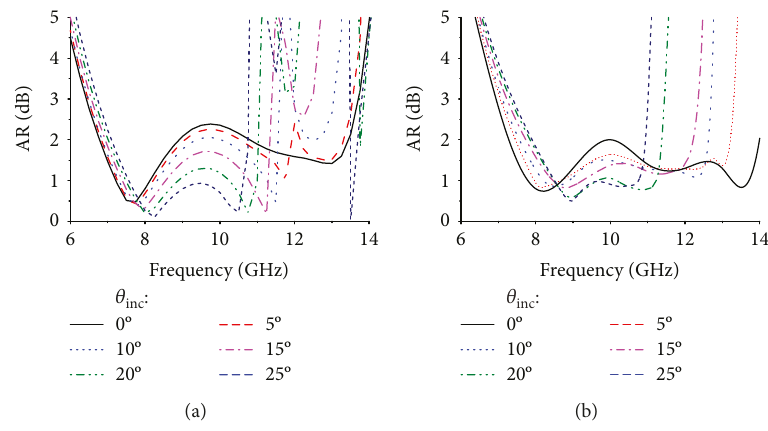
Figure 9: AR varied as the incident angle. (a) Simulated AR. (b) Measured